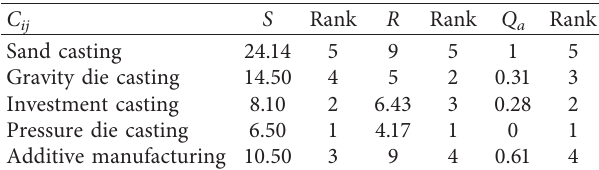
Table 13: Ranking of manufacturing processes depending on S , R , and Q .